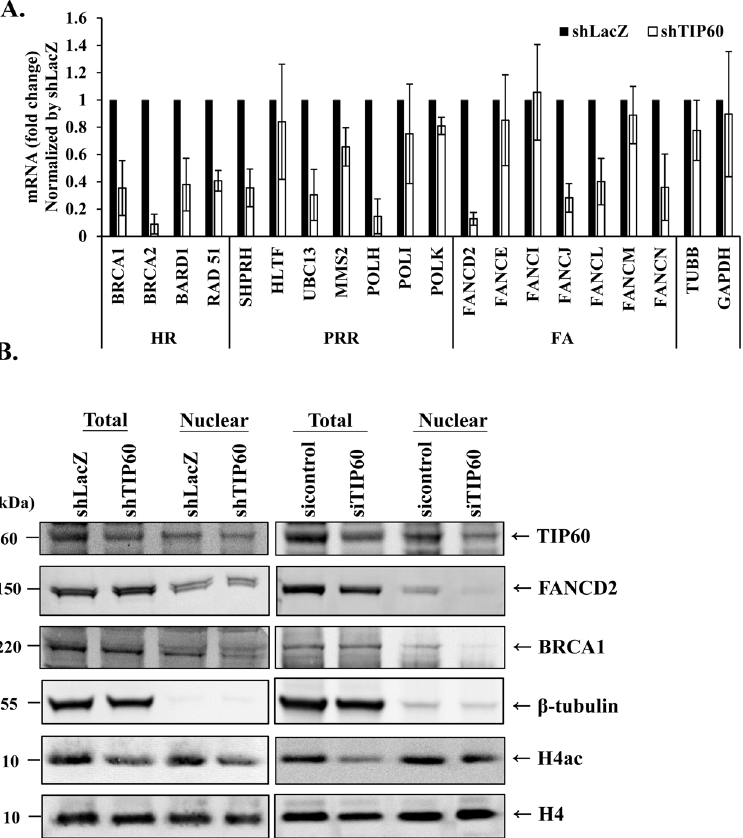
Figure 7. The expression of genes in the HR, TS, FA and TLS pathways are reduced in TIP60-deficient cells. ( A ) The expression levels of genes in the control and TIP60-deficient cells were determined by qRT-PCR and normalized by the levels in the control cells. Each value derived from qRT-PCR represents the mean ± standard deviation from at least three experiments. ( B ) The protein expression levels in the control and TIP60-deficient cells, including shRNA and siRNA knockdown, was determined by Western blotting with specific antibodies as indicated. Total proteins and the nuclear fraction were indicated. Full-length blot is presented in Supplementary Figure